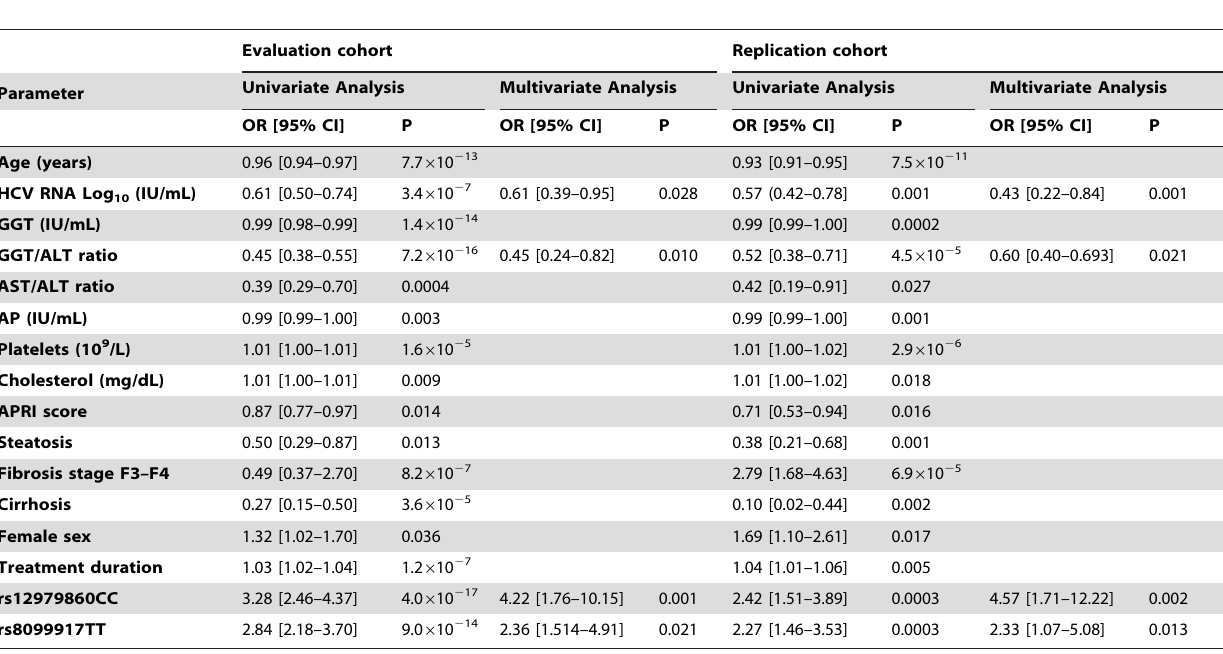
Table 3. Univariate and multivariate analyses of factors predictive for sustained virologic response